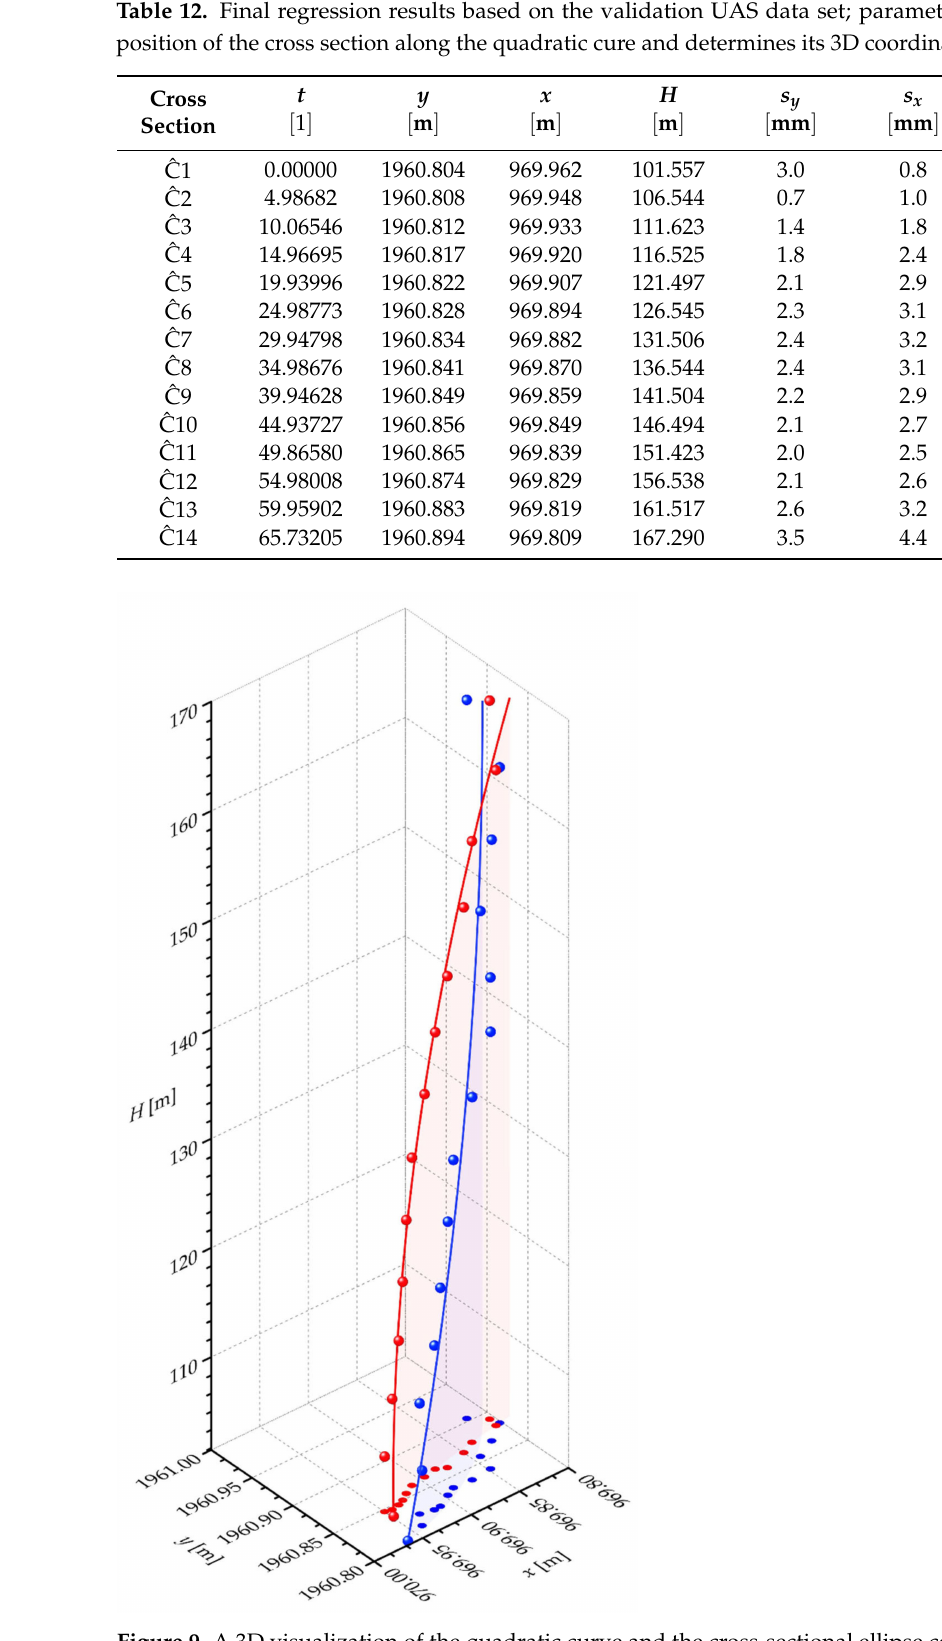
Figure 9. A 3D visualization of the quadratic curve and the cross-sectional ellipse centers on which the curve is determined, individually for the reference TS-based data set (red) and the validation UAS-based data set